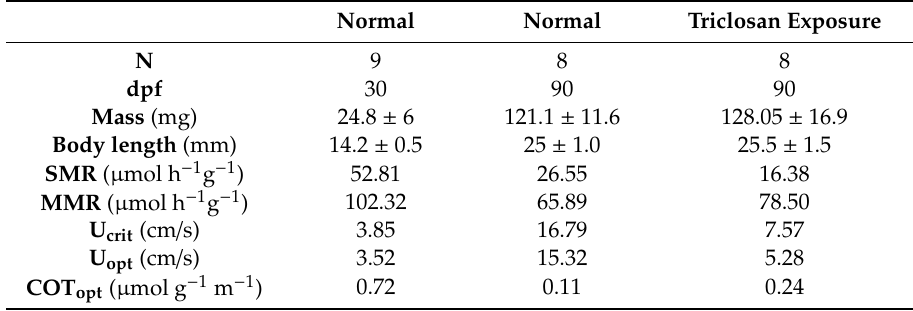
Swimming performance and energetic metabolism of 30 and 90 dpf zebrafish for standard metabolic rate (SMR), maximum metabolic rate (MMR), critical swimming speed (U crit ), optimal swimming speed (U opt ) and optimal cost of transport (COT opt ) at (U opt ) with and without Triclosan exposure. Normal Normal Triclosan